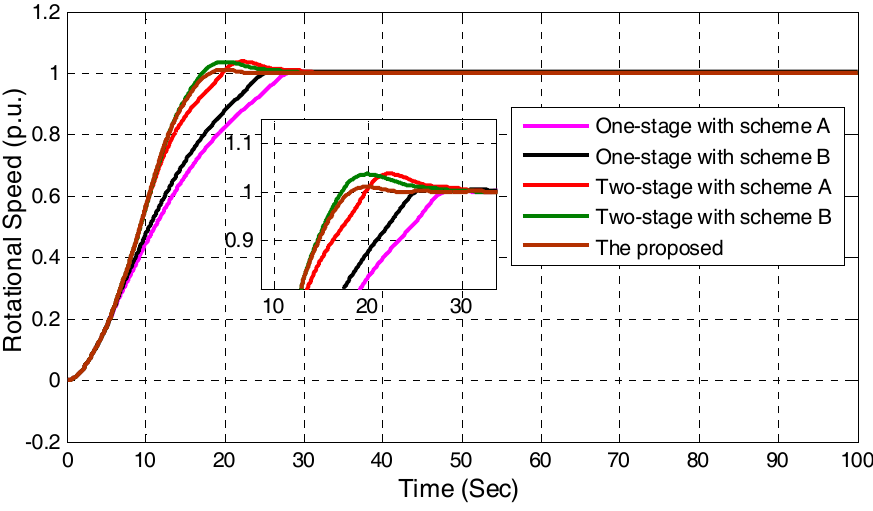
Figure 20. Comparison of rotational speed of each start-up strategy.